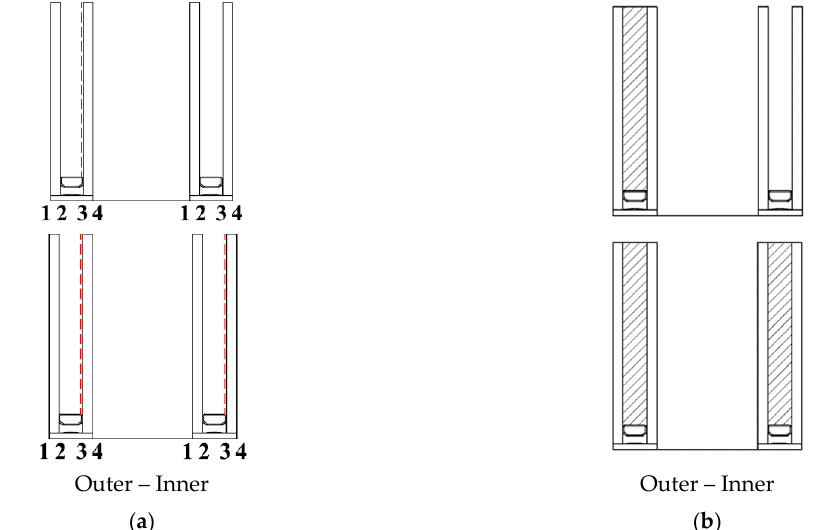
Figure 5. Locations of low-e coating and argon gas filling in the double glazing: ( a ) low-e coating; ( b ) argon gas filling.